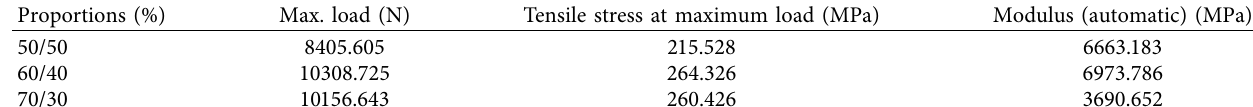
Table 2: Tensile stress and modulus for glass/epoxy composites.